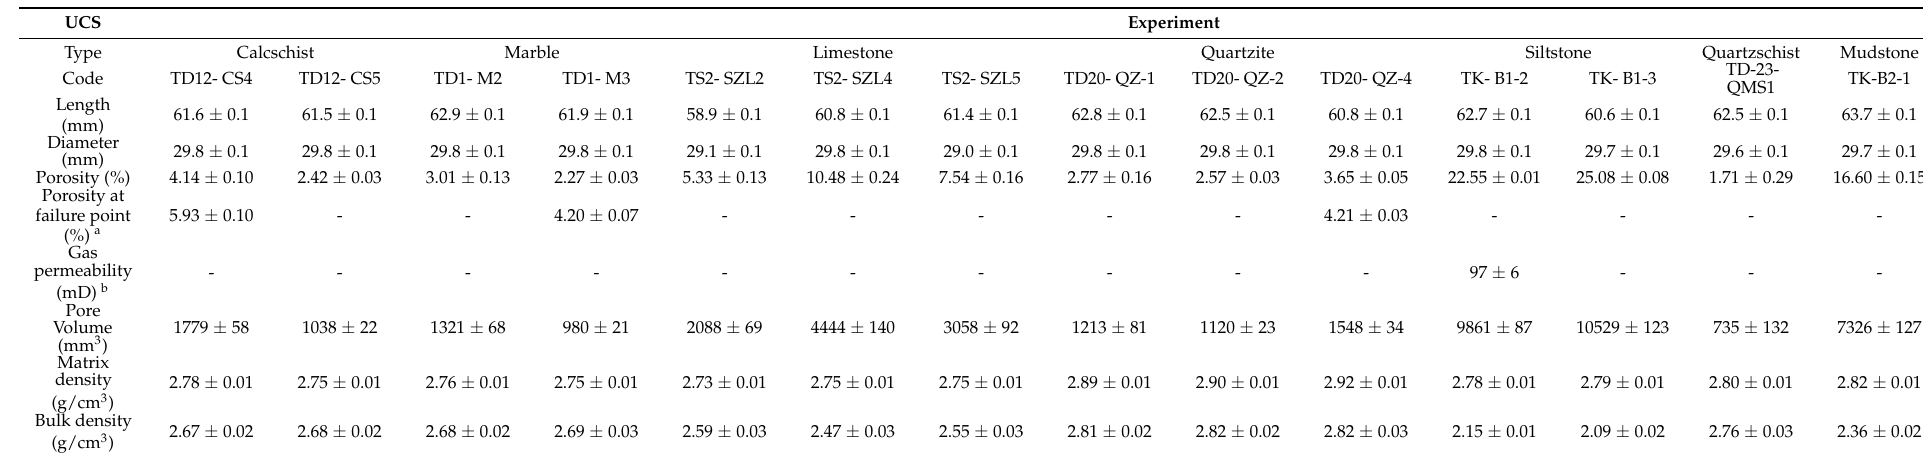
Table 2. Properties of the core samples used in experimental series A: UCS